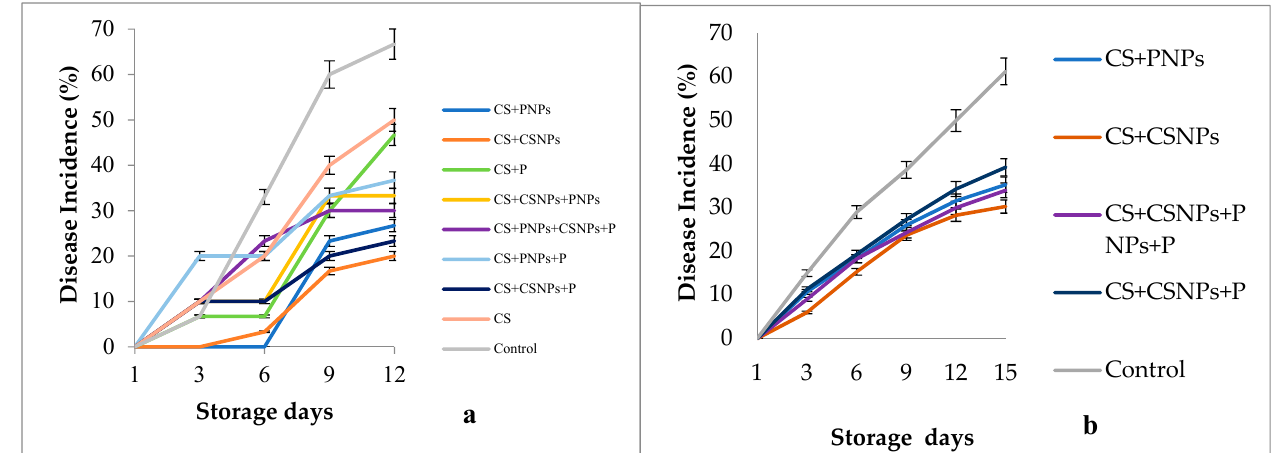
Figure 3. Effect of edible chitosan/propolis coatings on the incidence of A. flavus in fig fruit stored for 12 days at 4 °C under: ( a ) laboratory and ( b ) semi-commercial conditions. CS (chitosan), P (propolis extract), CSNPs (chitosan nanoparticles), PNPs (propolis nanoparticles).